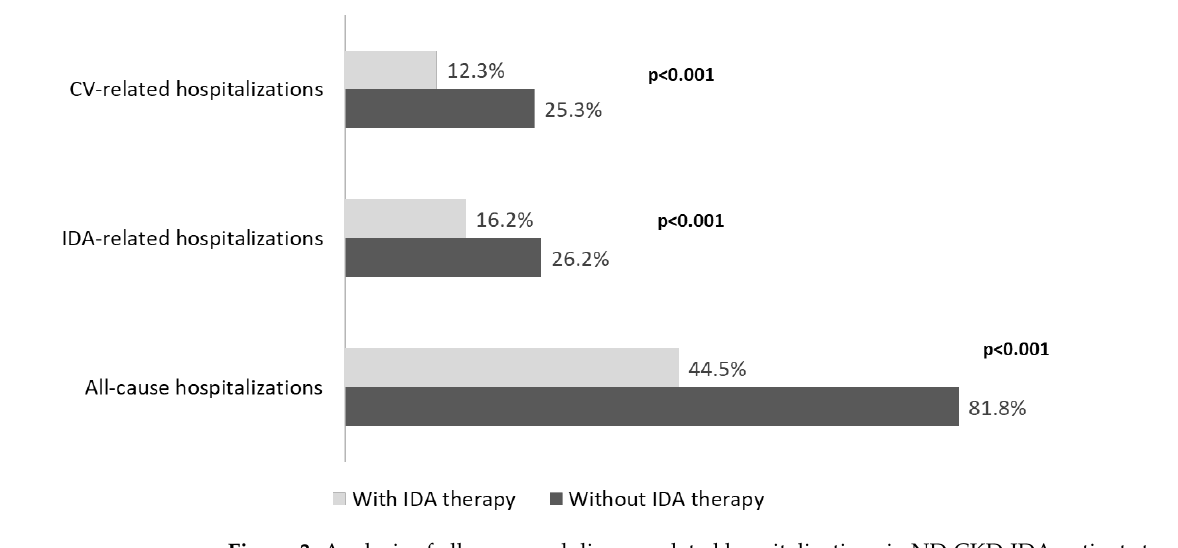
Figure 3. Analysis of all-cause and disease-related hospitalizations in ND-CKD-IDA patients treated or not with IDA therapy, during the follow-up, post PSM. CKD, chronic kidney disease; IDA, iron- deficiency anaemia; ND, non-dialysis; PSM, propensity score matching; CV, cardiovascular.